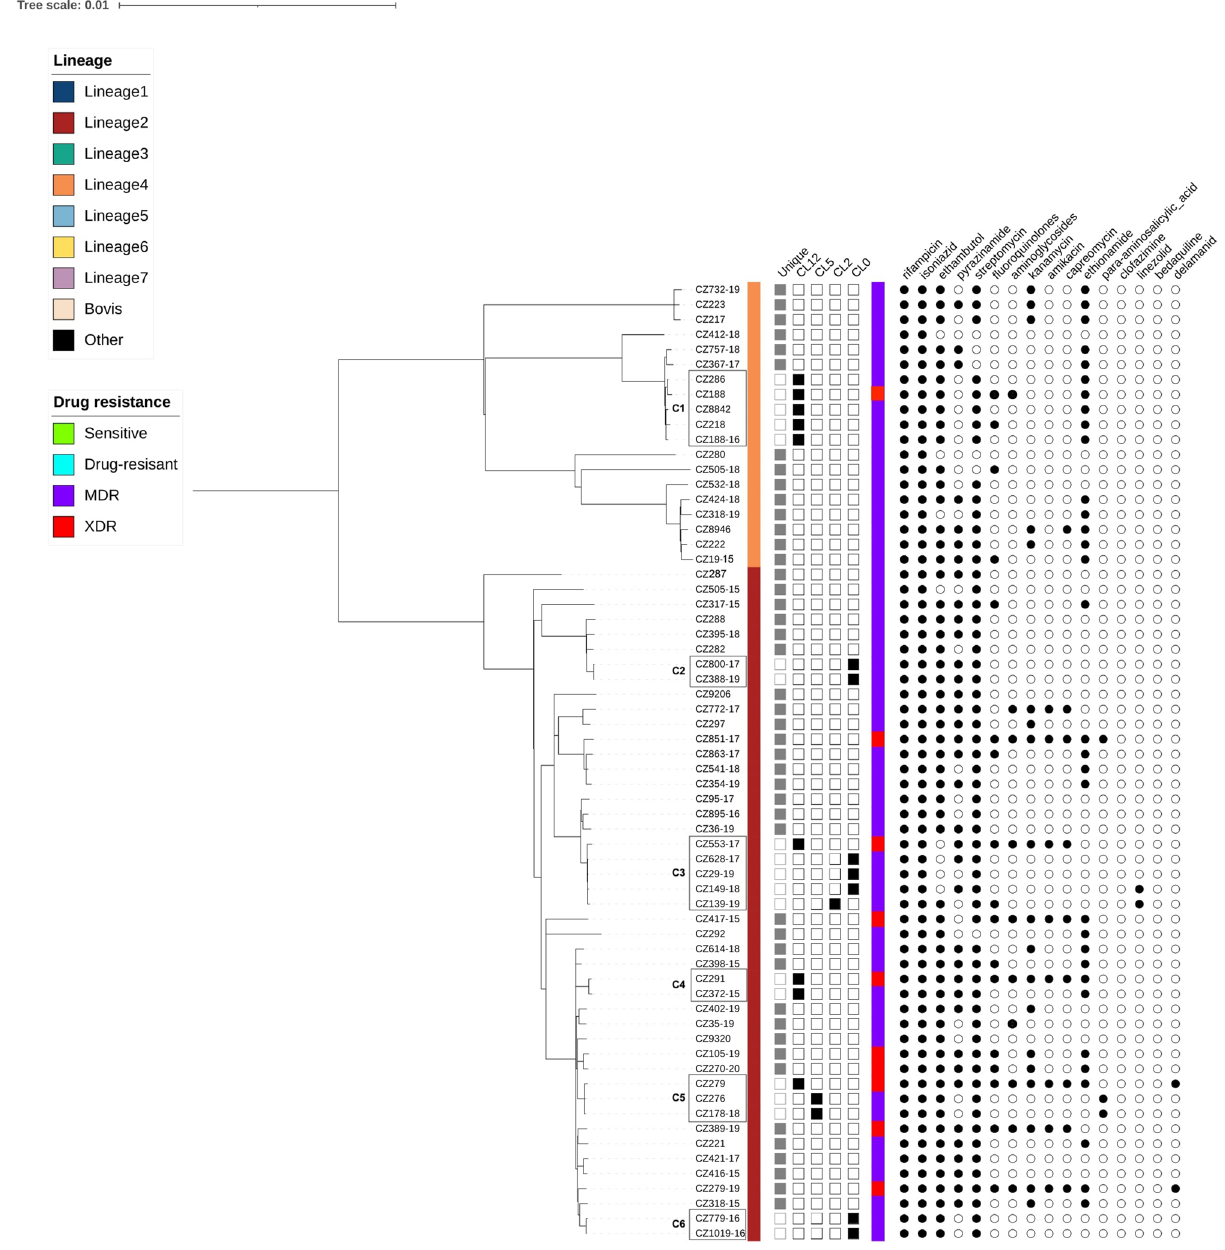
Figure 2. Maximum likelihood phylogenetic tree generated from 64 MDR isolates collected in the Czech Republic during the years 2005–2020 together with their lineage, cluster assignment, and genotypic resistance to first- and second-line antituberculosis drugs. The tree was annotated using iTOL v6 (https:// itol. embl. de/). The first column denotes the lineages. The next 5 columns show genomic relatedness within clusters (CL12, CL5, CL2 and CL0—sets the maximum number of SNPs that differ from the genetically closest isolate). Mutations encoded resistance are represented by filled circles (presence of mutation) or empty circles (absence of mutation) icons. MDR multi-drug resistant, XDR extensively-drug resistant, drug-resistant (including mono- and